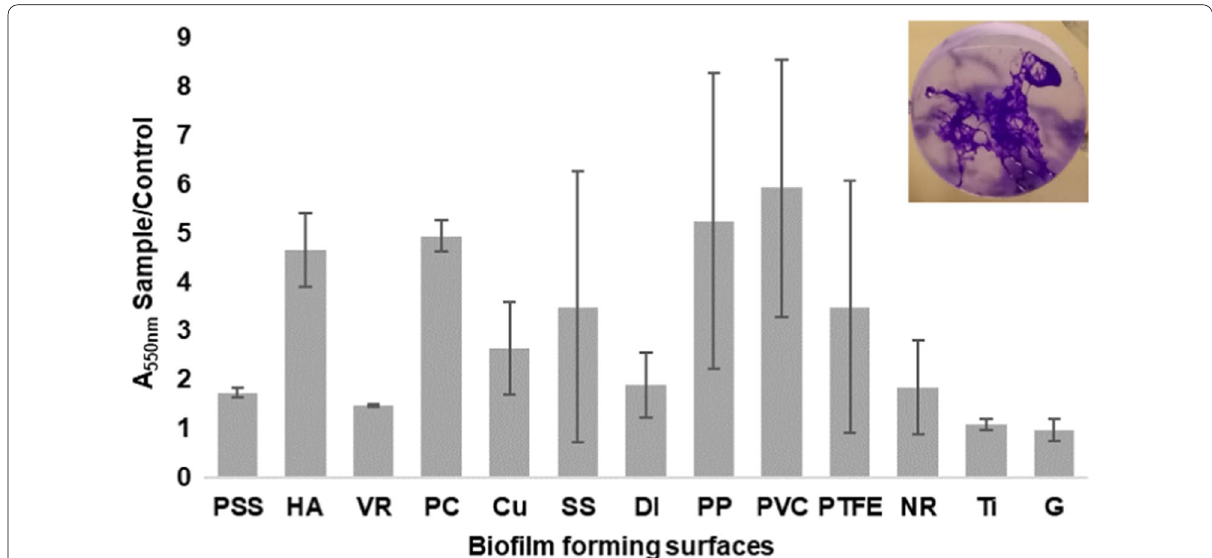
Fig. 1 Biofilm forming ability of V. paradoxus strain BFB1_13 on polished stainless steel (PSS), hydroxyapatite (HA), viton rubber (VR), polycarbonate (PC), copper (Cu), stainless steel (SS), ductile iron (DI), polypropylene (PP), polyvinyl chloride (PVC), polytetrafluoroethylene (PTFE), natural rubber (NR), titanium (Ti) and glass (G). The ratio of absorbance values obtained at 550 nm (A 550nm ) of biofilm containing coupons (Sample) and abiotic control coupons (Control) is shown. A crystal-violet stained biofilm of strain BFB1_13, developed on polycarbonate surface is shown in the top right-hand corner. The average of three replicates is shown, error bars represent standard deviations